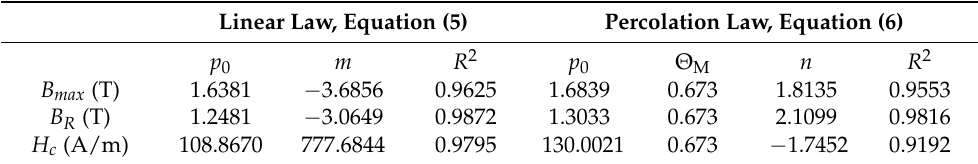
Values of the parameters obtained by fitting the magnetic experimental data to Equations (5) and (6). Linear Law, Equation (5) Percolation Law, Equation (6) p